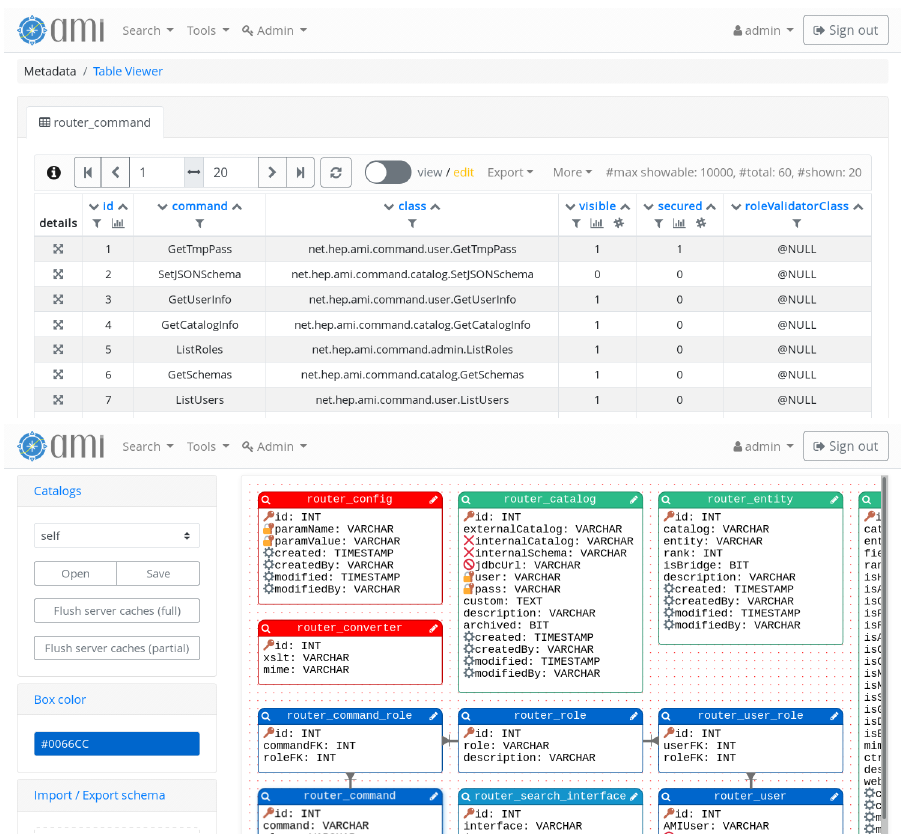
Fig. 6. At top, an AWF application with a data table. At bottom, the AWF database schema explorer.